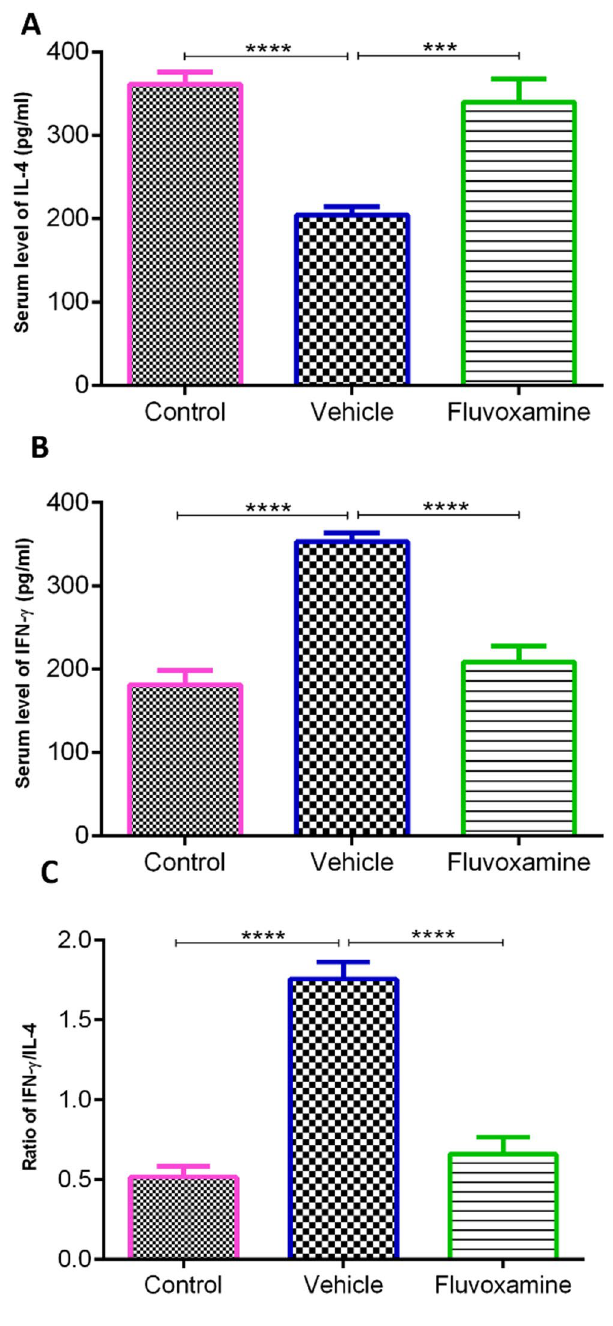
Figure 7. Concentrations of cytokines in serum samples using enzyme-linked immunosorbent assay. ( A ) IL-4 anti-inflammatory cytokine and ( B ) IFN- γ pro-inflammatory cytokine levels were measured in all rats on day 17. Fluvoxamine significantly reduced the levels of IL-4, while increasing the levels of IFN- γ , compared to EAE controls (p < 0.001 and p < 0.0001, respectively). ( G ) Ratio of IFN- γ /IL-4. Values represent the mean ± SEM. *** p < 0.001, **** p <